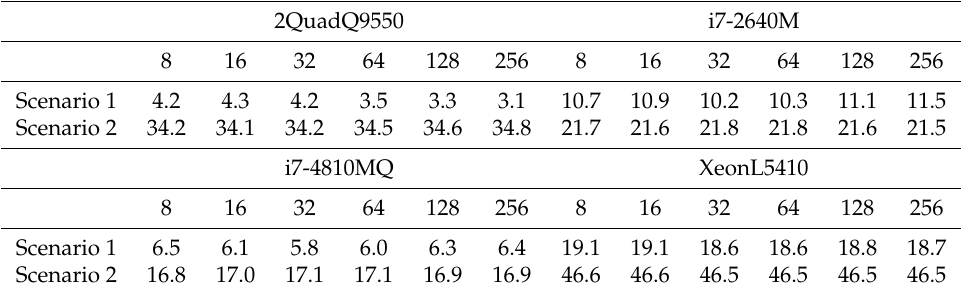
Percentage of energy consumption savings on the memory hierarchy for our two bypassing